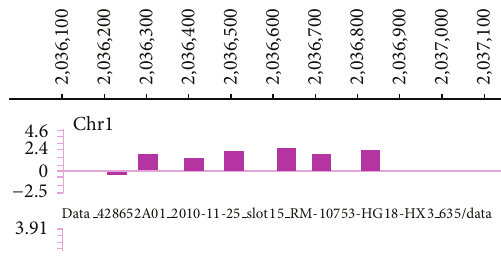
Figure 1: Chromosome 1 promoter region, ◼ illustrating detection probe sites of the